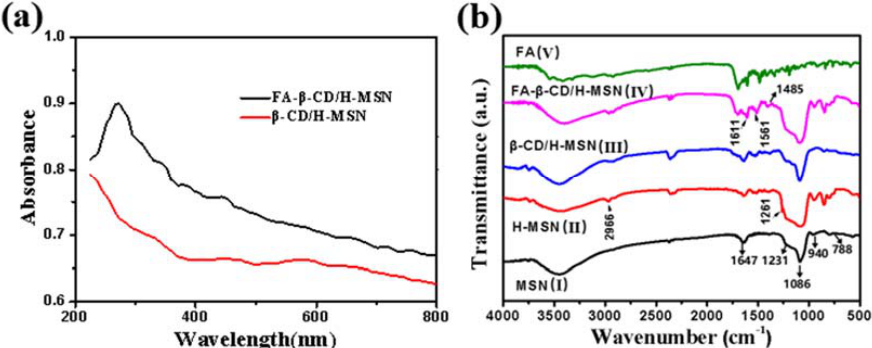
Figure 2. ( a ) Absorption spectra of β -CD/H-MSN (red) and FA- β -CD/H-MSN (black). Comparing with the spectrum of β -CD/H-MSN, the spectrum of FA- β -CD/H-MSN had a special peak at 272 nm, indicating the successful modification of folic acid; ( b ) FT-IR spectra of MSN, H-MSN, β -CD/H-MSN, FA- β -CD-H-MSN, and FA (bottom to top). The emergence of the bands at 1611 and 1516 cm − 1 is due to amide I and amide II bonds, which further illustrated the successful connection of FA.